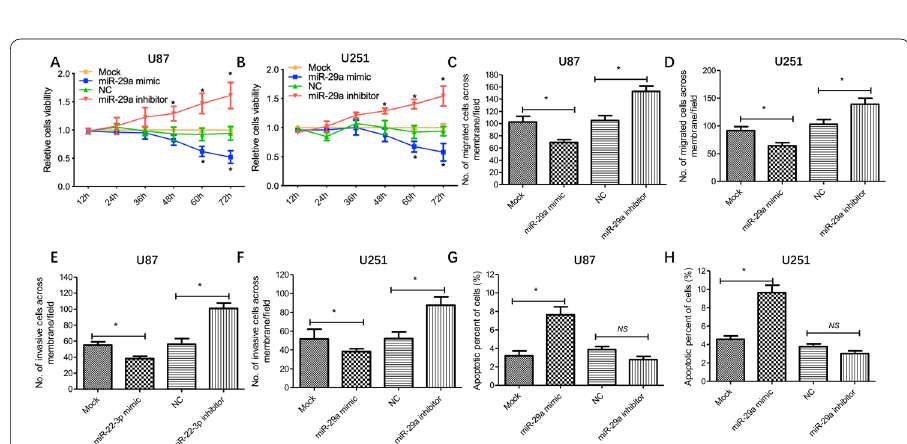
Fig. 2 miR-29a affects glioma cell proliferation, migration, invasion and apoptosis in vitro. After miR-29a mimic, inhibitor or corresponding control treatment, proliferation (U87:A; U251:B), migration (U87:C; U251:D), invasion (U87:E; U251:F) and apoptosis (U87:G; U251:H) of glioma cells were measured by CCK-8 assay, transwell assay and flow cytometry. Results represent the mean value